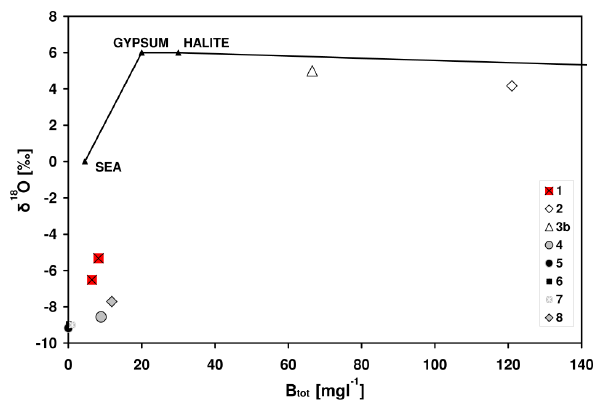
Fig. 10. Reservoir-concept model of the slope. Water volumes ( V r : annual rainfall volume; V dw : annual deep water volume inflow; V f : annual volume of water hosted inside the flysch; V OUT : annual wa- ter outflow volume) and their corresponding isotopic